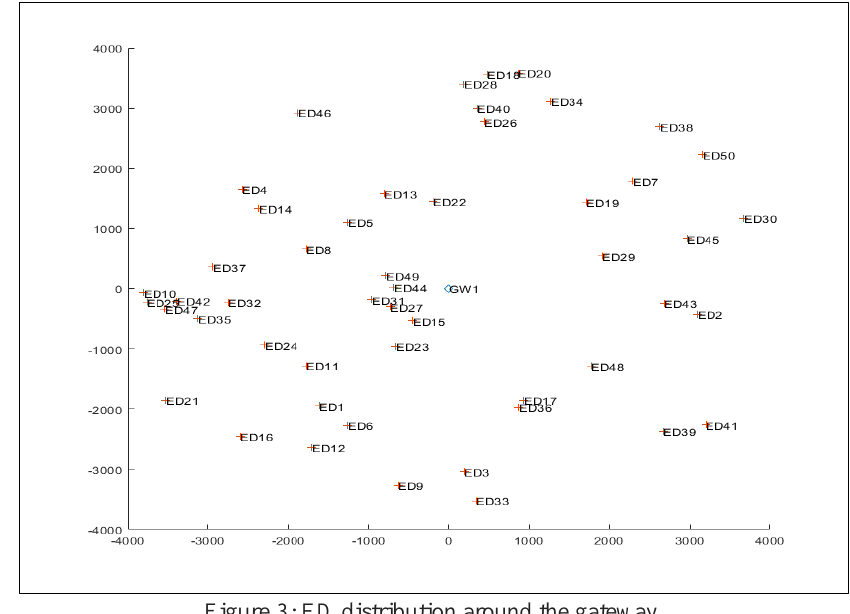
Figure 3: ED distribution around the gateway.